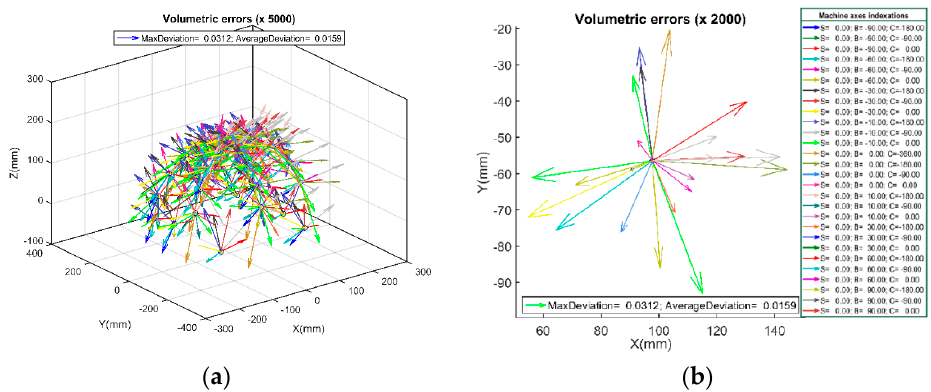
Figure 5. Plotted deviation between compensated artefact by SAMBA and calibrated artefact, manually estimated tool is applied (item S4); ( a ) 3D view; the legend of the arrows’ colors is as on figure b. ( b ) Deviation for one ball in X-Y view for different machine axes and indexations (units are millimeter).